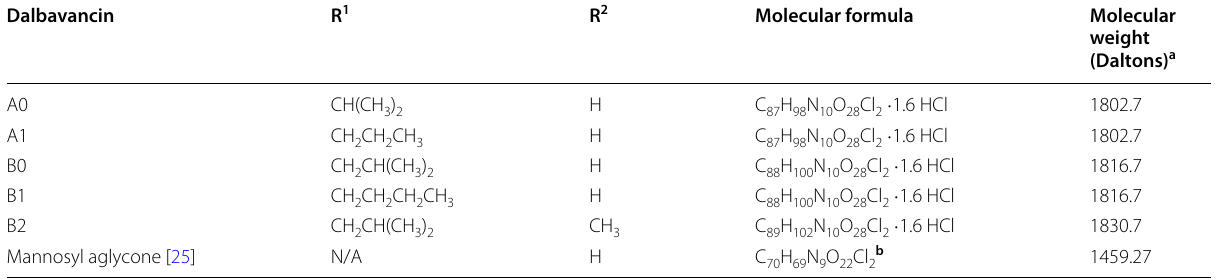
a Specified molecular weight for anhydrous free base b Molecular Formula derived from acylglucoronamine-free dalbavancin ([25], Structure II)